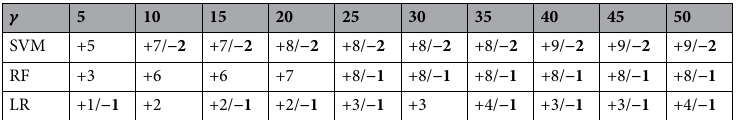
Table 4. Summary of the results, by classifier, for different values of the cost ratio γ = boxes indicate for how many data sets, of the possible 12, there is statistical significance in favor of BOSME (positive) or in favor of SMOTE (negative, in bold).